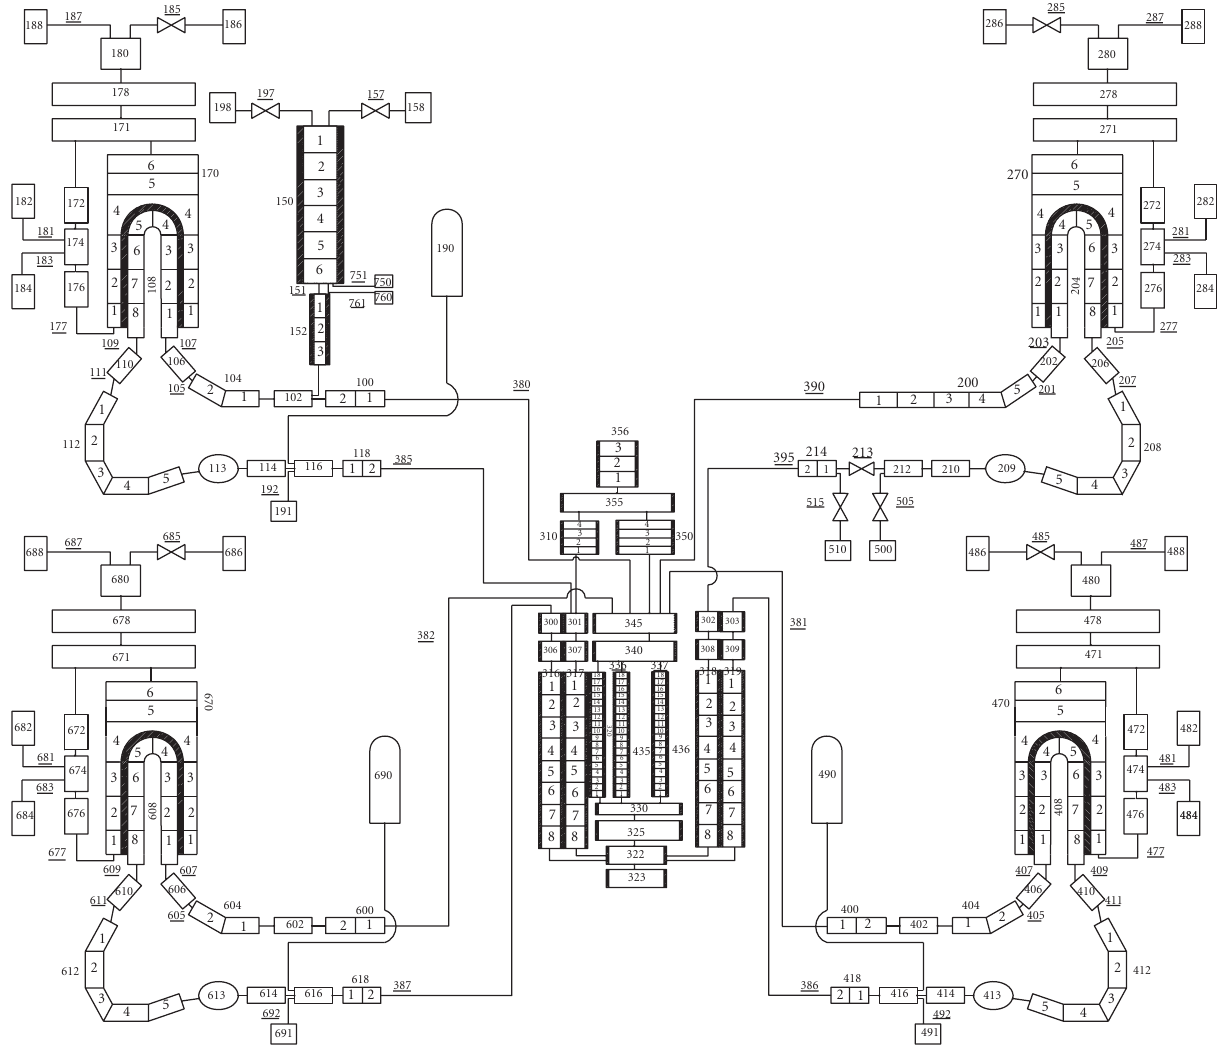
Figure 2: Example of 1-D Relap5 nodalization scheme used by